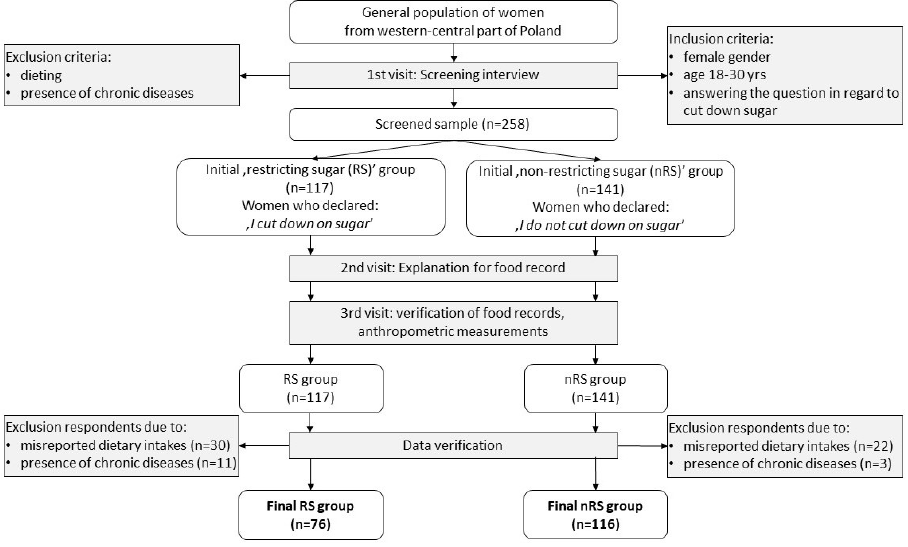
Figure 1. Study design and data collection.